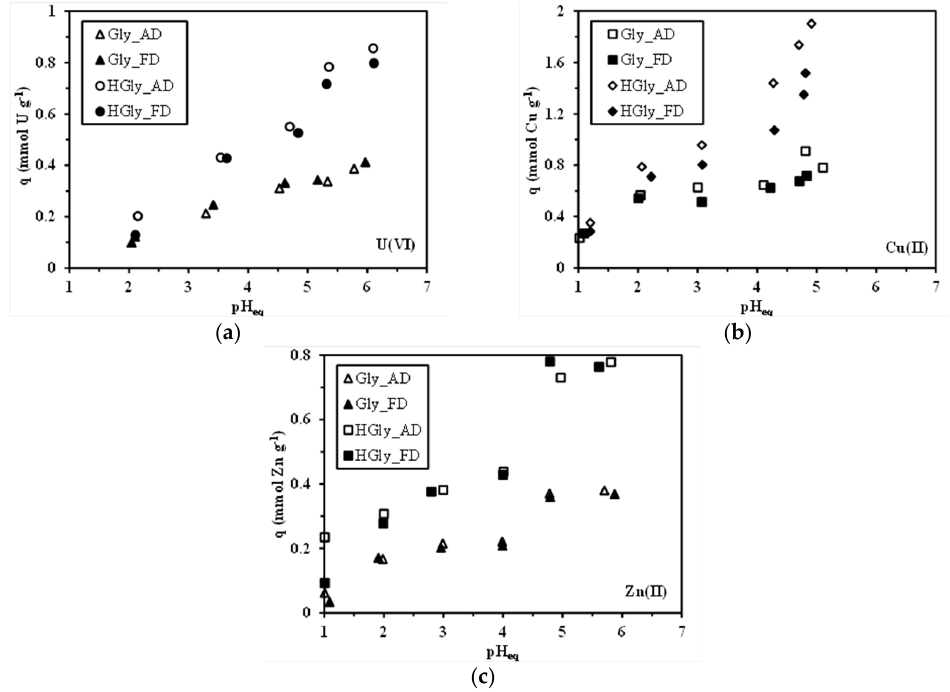
Figure 1. Effect of pH on the sorption of U(VI) ( a ); Cu(II) ( b ); and Zn(II) ( c ) using Gly and